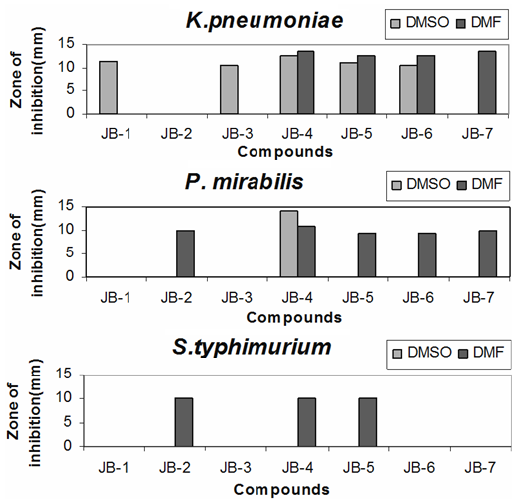
Figure 2: Antibacterial activity of azomethines against Gram negative bacteria in DMSO and